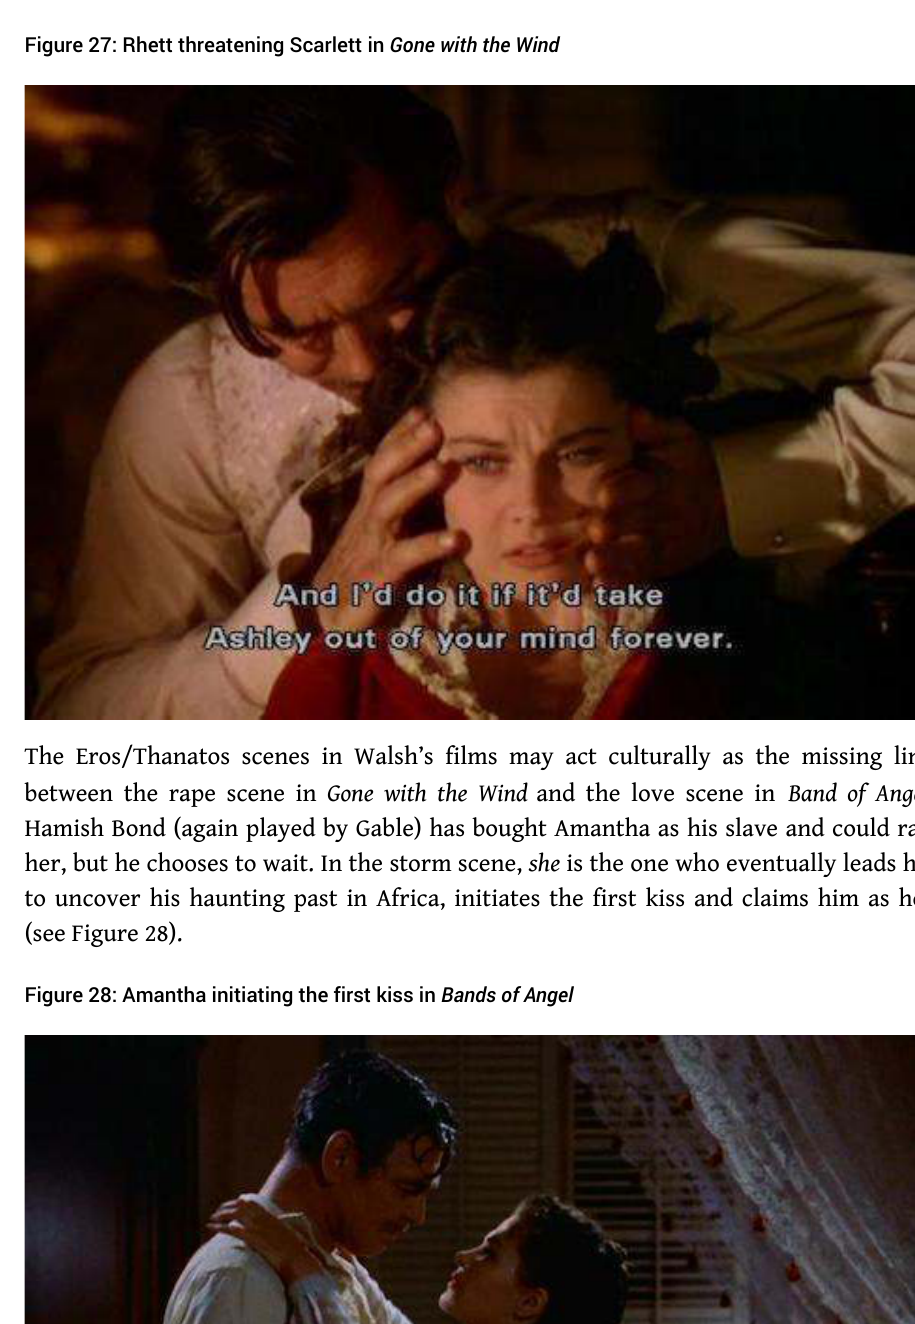
Figure 27: Rhett threatening Scarlett in Gone with the Wind